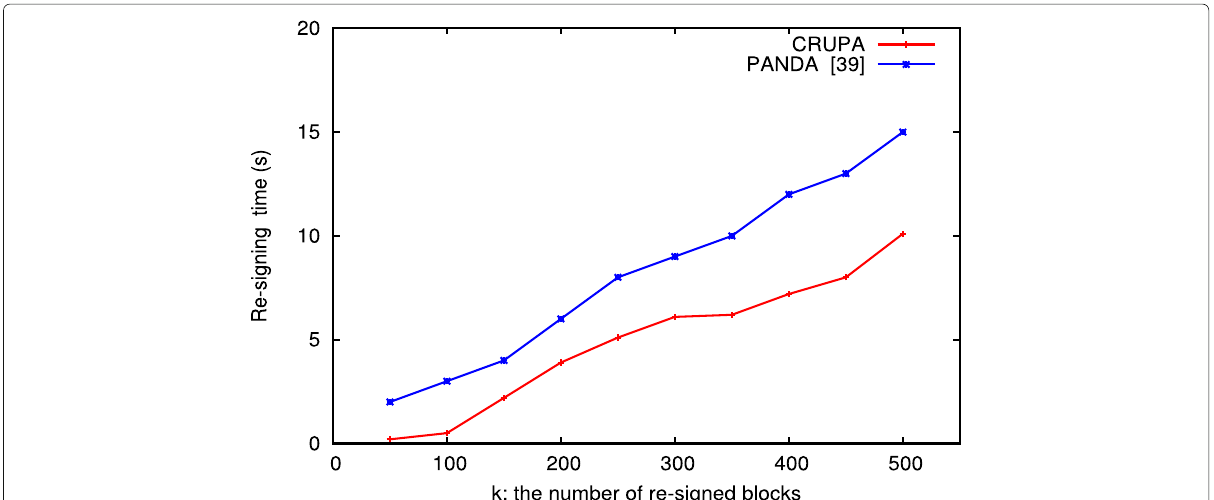
Fig. 5 Re-signing time of the blocks by Cloud Service